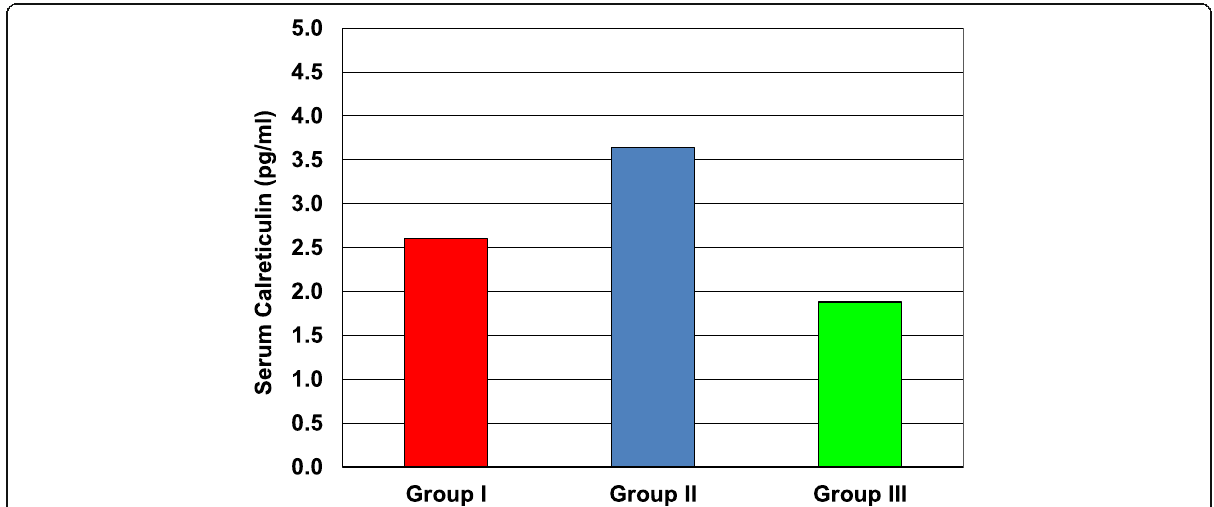
Fig. 2 Serum calreticulin (CRT) (ng/ml) in renal transplant recipients with stable allograft function (group I), chronic allograft dysfunction (group II), and in control subjects (group III)